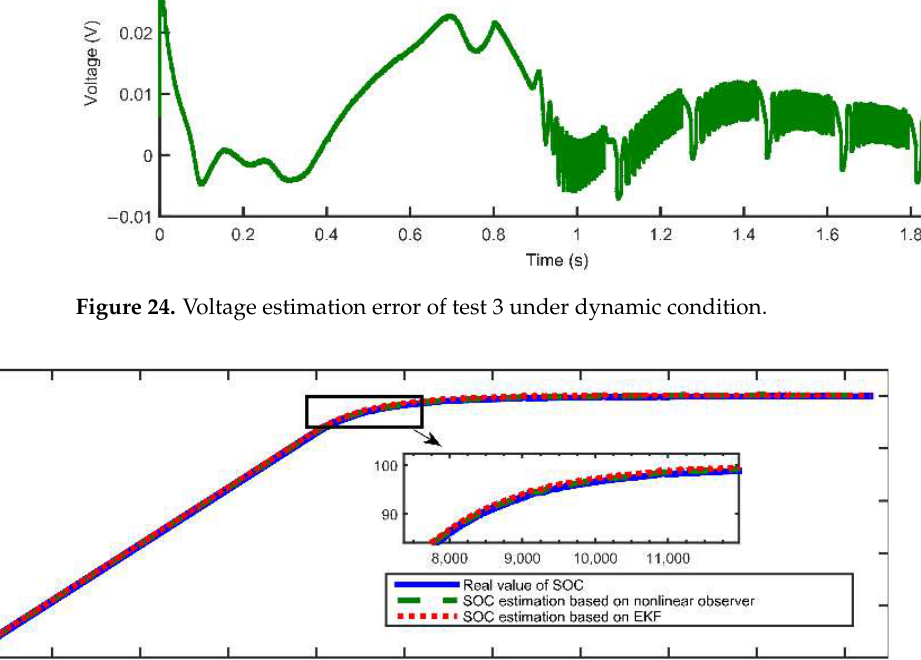
Figure 26. Comparison of SOC estimation error based on non-linear observer and EKF in dynamic condition test 3. To further show the accuracy of the proposed RBF neural network non-linear ob- server in estimating the SOC of the EKF method, Table 2 gives the RMSE results of esti- mating the SOC using the proposed RBF neural network non-linear observer and the EKF method under three dynamic operating conditions tests. Figures 12, 21 and 26 and Table 2 show that the RBF non-linear observer designed has higher estimation accuracy than the EKF. Table 2. RMSE of SOC estimation error based on RBF neural network non-linear observer and EKF method.